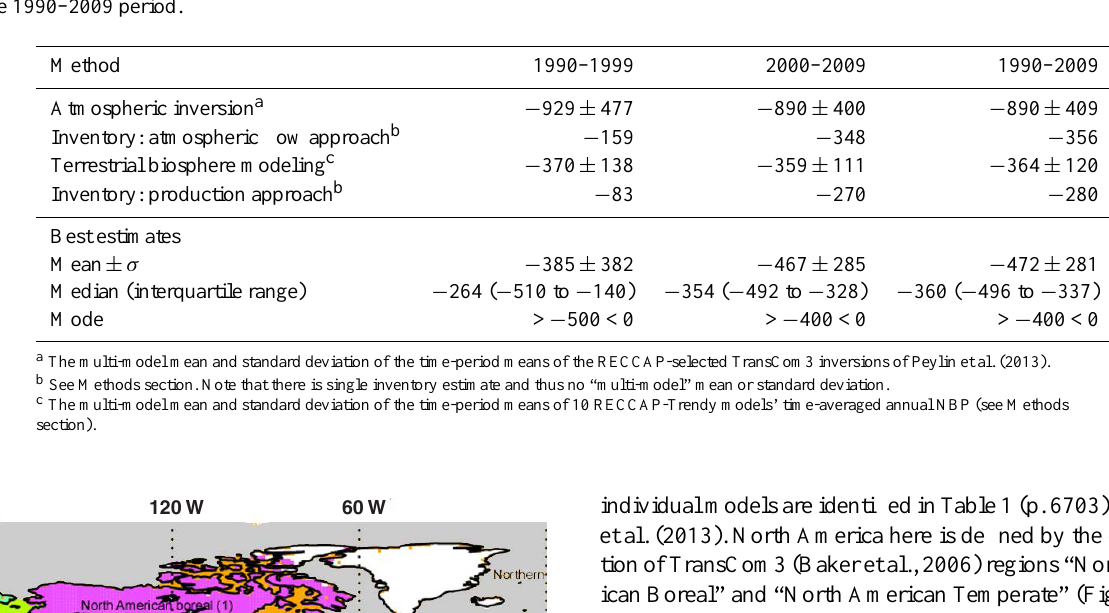
Table 1. Mean ± 1 standard deviation ( σ) of annual net land–atmosphere exchange of CO 2 -C (TgCyr − 1 ) for North America by decade and for the 1990–2009 period.